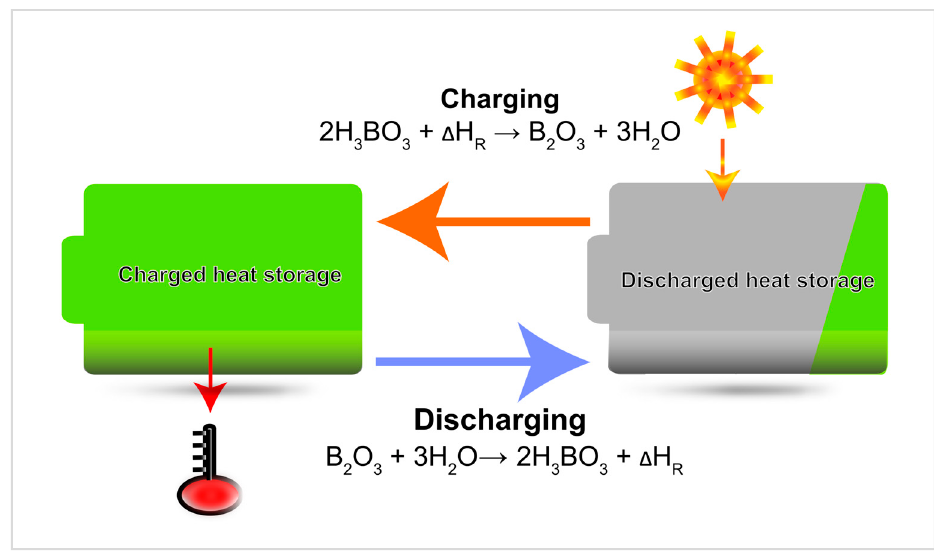
Figure 1. Schematic thermochemical energy storage process illustrated by the boric acid/boron oxide reaction.